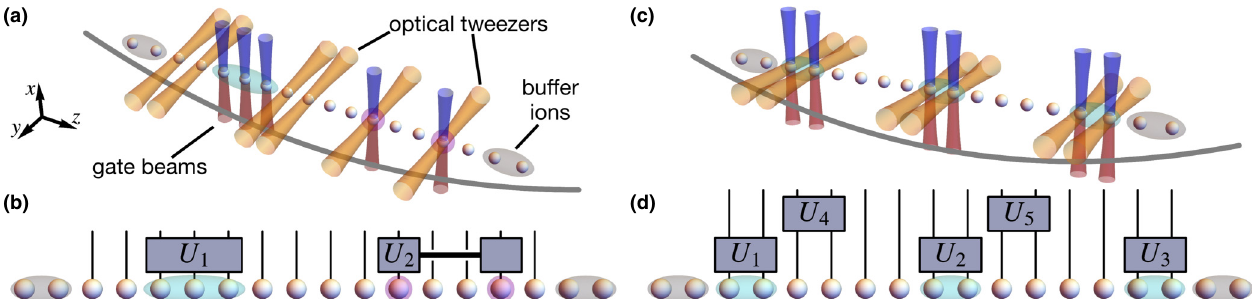
FIG. 1. Schematic setup and circuits. (a) Specific ions in a long 1D chain are pinned by optical tweezers. This leads to the formation of localized phonon modes, e.g., for the subregister formed by the three ions that are marked by cyan shading, and for the pair of distant qubits that are marked by pink shading and are pinned by equally strong optical potentials. (b) The localized phonon modes can be utilized to implement multiqubit entangling gates. Buffer ions at the ends of the chain are not used as qubits. Addressed lasers, which are required to perform entangling gates, are indicated schematically in (a) as blue and red beams. (c) In this work, we focus on implementing parallel two-qubit entangling gates, which use the localized phonon modes of pairs of neighboring pinned ions. (d) After a first layer of the circuit, which corresponds to the product of gates U 1 U 2 U 3 that act on distinct qubits, the tweezers are focused on different ions to perform the second layer corresponding to the gate operation U 4 U 5